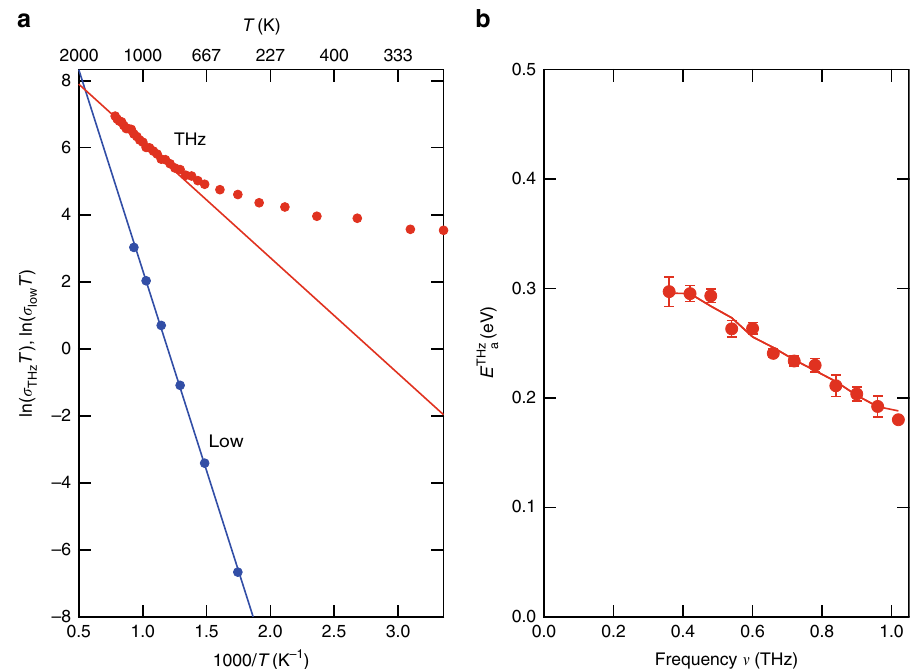
Fig. 4 Temperature dependence of the THz conductivity in 8YSZ. a Red closed circles represent the temperature dependence of the THz conductivity in 8YSZ at 0.36 THz. Blue closed circles show the conventionally measured low-frequency conductivity in 8YSZ. The solid lines are the fi tting results obtained using the Arrhenius equation. b The data points show the activation energy evaluated from the THz conductivity of 8YSZ at different frequencies. The solid smoothing curve is a guide to the